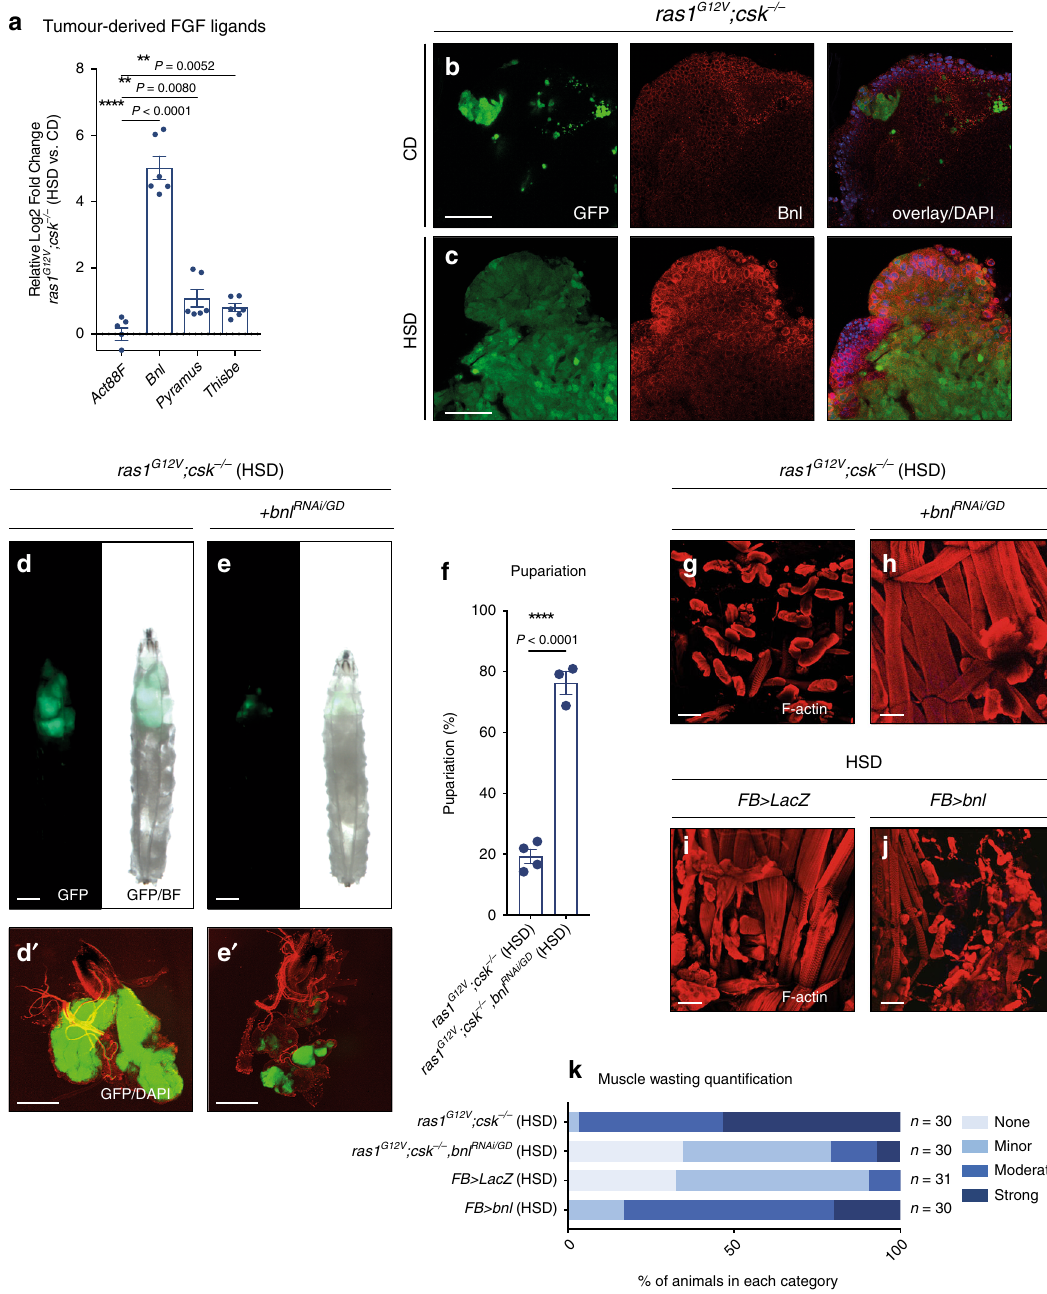
Fig. 2 Tumour-derived branchless mediates muscle wasting and tumour growth. a Relative log2fold change of Drosophila fi broblast growth factors, branchless ( bnl ), pyramus and thisbe in dissected tumour tissue from ras1 G12V ;csk − / − animals raised on HSD compared to animals raised on CD, as determined by qPCR. Samples are normalised to Act88F . Results are shown as mean ± SEM. Data from n = 6 biologically independent samples. Data were analysed by two-tailed unpaired Student ’ s t test. Asterisks indicate statistically signi fi cant difference (** P < 0.01; **** P < 0.0001). Anti-Bnl staining (red) of dissected tumour tissue from ras1 G12V ;csk − / − animals raised on CD ( b ) or HSD ( c ) with DAPI (blue). Scale bar, 40 μ m. Third-instar larvae from ras1 G12V ;csk − / − ( d ), and ras1 G12V ;csk − / − ,bnl RNAi /GD ( e ). Scale bar, 500 μ m. d ′ , e ′ Matching dissected eye epithelial tissue stained with DAPI (red). Scale bar, 250 μ m. f Pupariation percentage of ras1 G12V ;csk − / − , and ras1 G12V ;csk − / − ,bnl RNAi /GD animals raised on HSD. Results are shown as mean ± SEM. Data from total n = 120 ( ras1 G12V ;csk − / − ), and n = 125 ( ras1 G12V ;csk − / − ,bnl RNAi /GD ) from four independent experiments. Data were analysed by two-tailed unpaired Student ’ s t test. Asterisks indicate statistically signi fi cant difference (**** P < 0.0001). F-actin (red) staining of dissected larval body-wall muscle tissue from ras1 G12V ;csk − / − ( g ) or ras1 G12V ;csk − / − ,bnl RNAi /GD ( h ) third-instar larvae raised on HSD. Scale bar, 100 μ m. F-actin (red) staining of dissected larval body-wall muscle tissue from FB > LacZ ( i ) or FB > bnl ( j ) third-instar larvae raised on HSD. Scale bar, 100 μ m. k Matching body-wall muscle wasting quanti fi